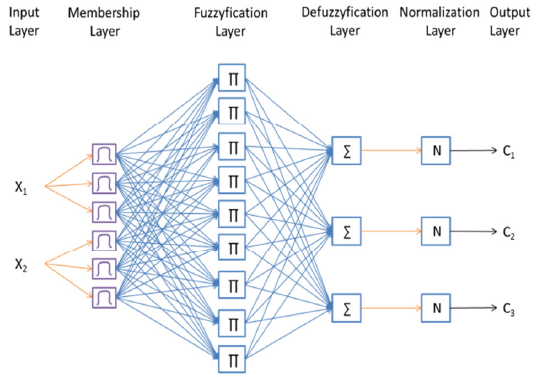
Figure 4. A neurofuzzy classifier (Ceti ş li and Barkana,